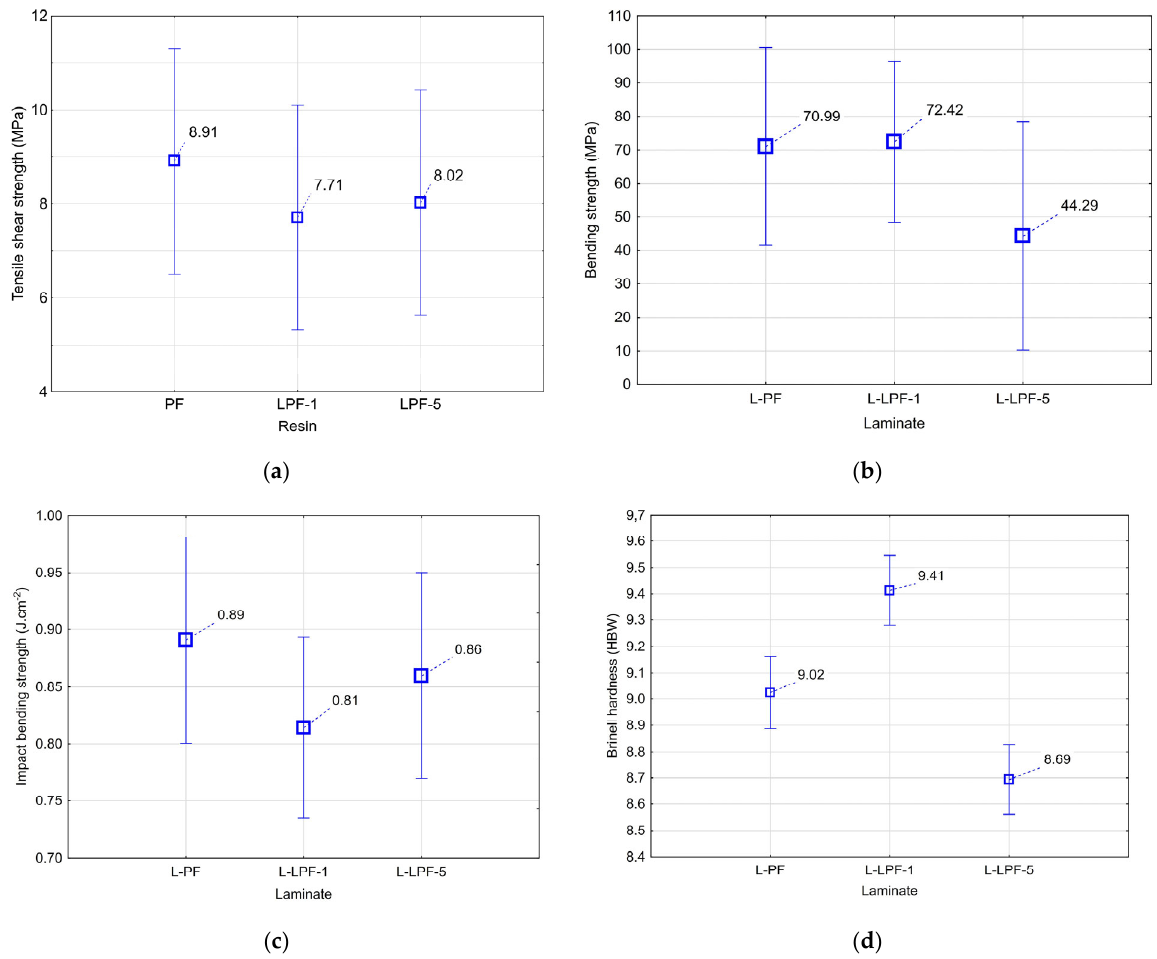
Figure 8. Influence of resin on ( a ) tensile shear strength, ( b ) bending strength, ( c ) impact bending strength, ( d ) Brinell hardness. Note: vertical bars represent 95% confidence intervals; p ‐ values are presented in Table 4. Table 4. The p ‐ values of differences presented in Figure 8 .